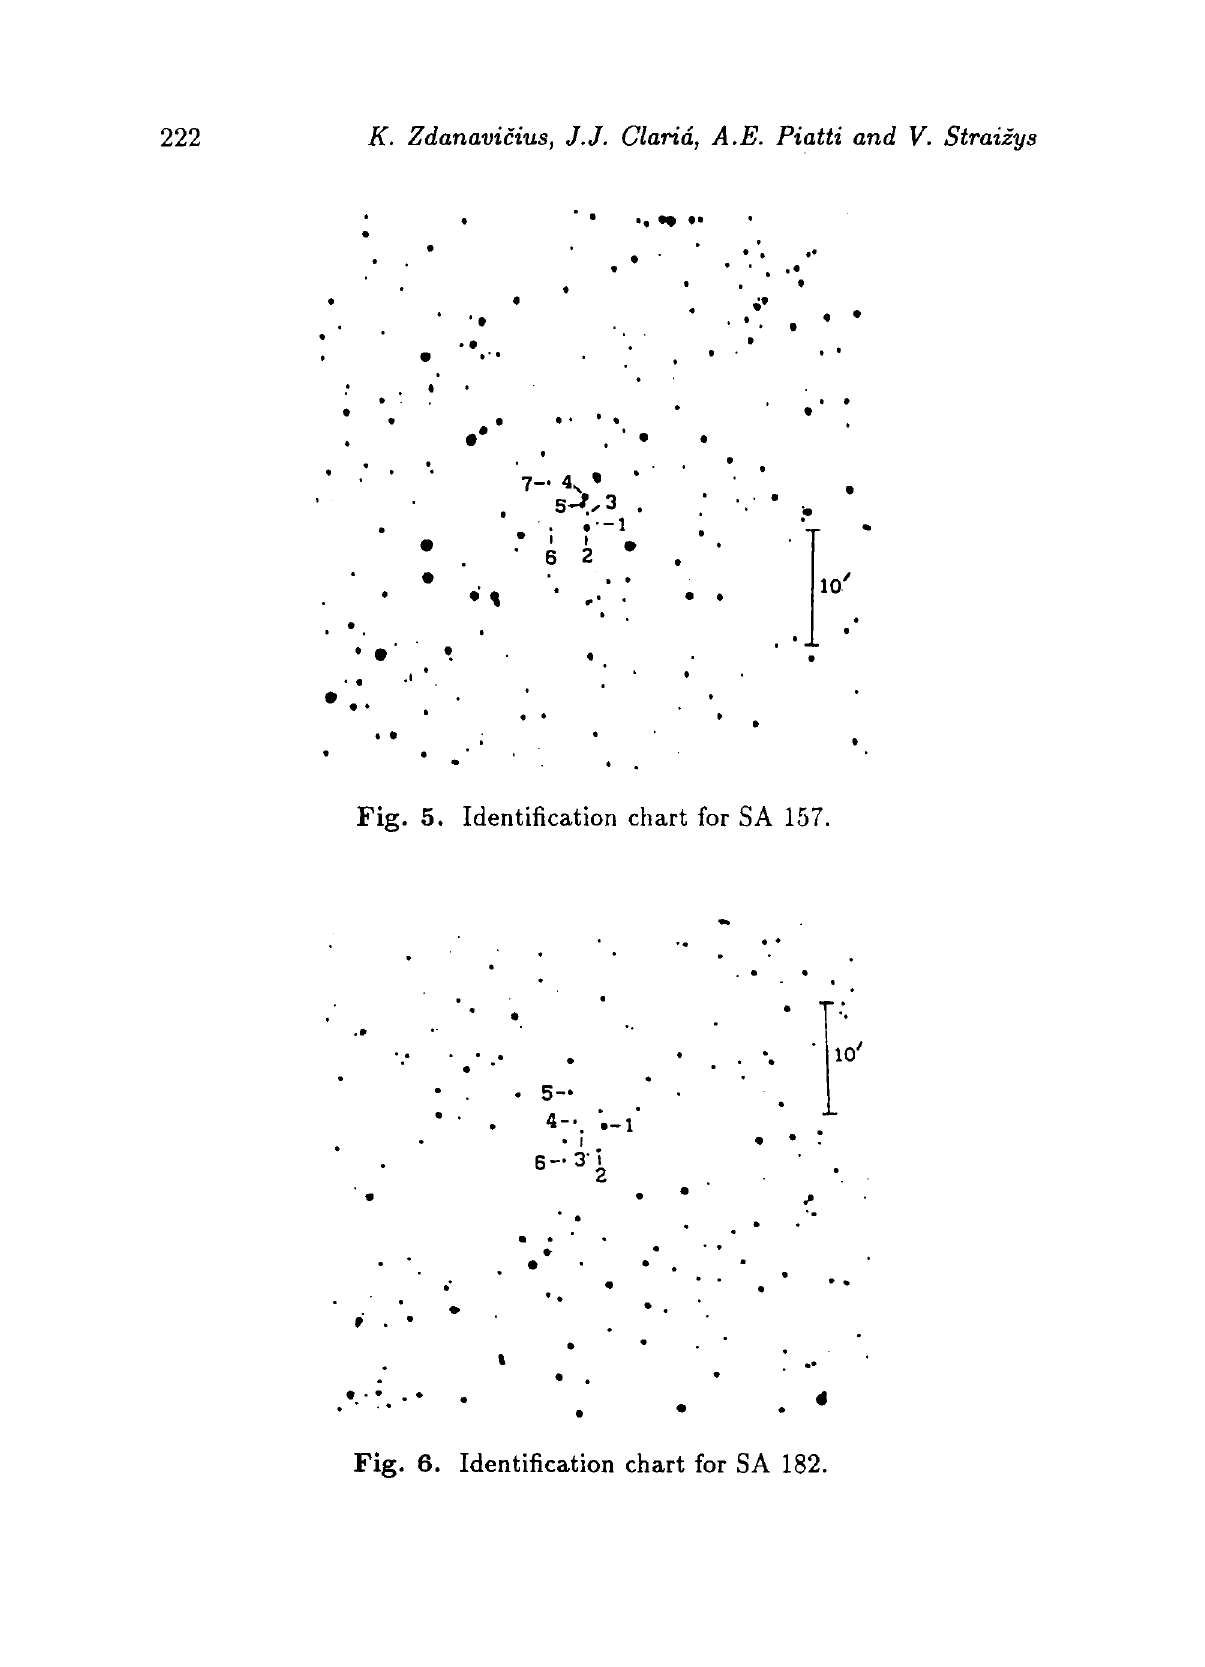
Fig. 6. Identification chart for SA